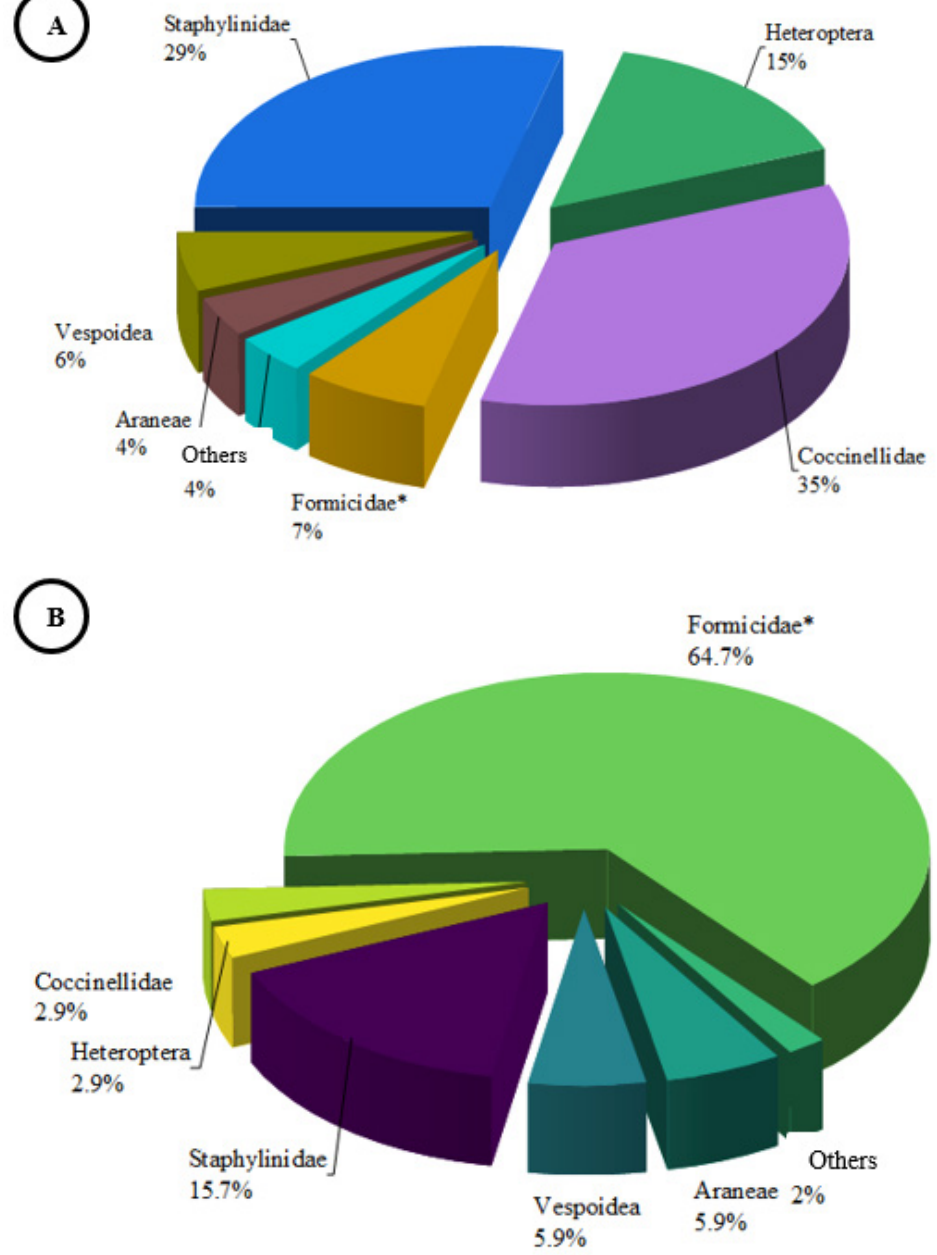
Fig 4. Proportion of predators taxon captured in the yellow adhesive trap ( 170 records ) and in the universal collector ( 352 records ). The collections were carried out in 18 localities of organic vegetable production in the Rashad , Sudan, from February to June 2020 and February to May 2021 , using 360 universal collectors and 360 yellow adhesive trap cards (A. Predators shown in the yellow sticky trap, B. Predators shown in universal collector) . In this figure, the family Dolichopodidae, with 128 individuals, has been suppressed. *For the Formicidae family, ants were counted in number of occurrence (244) instead of number of individuals